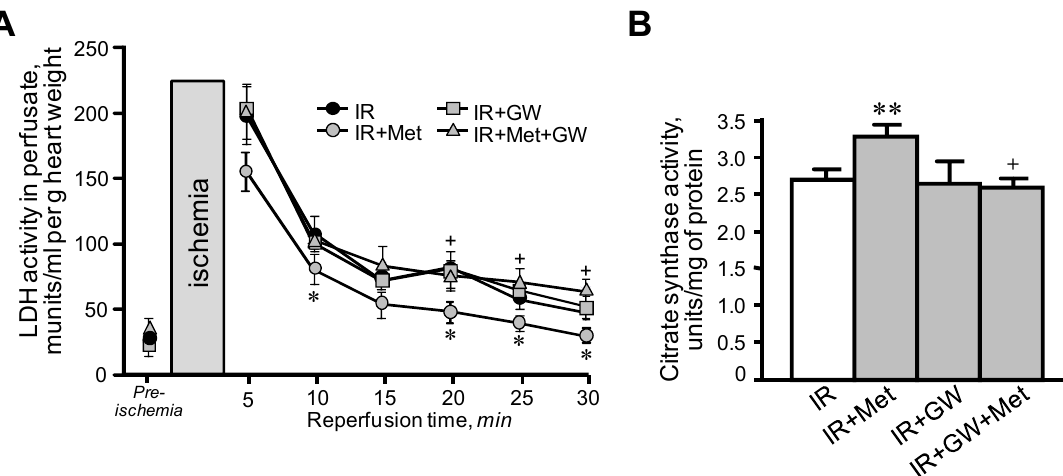
Figure 3. Lactate dehydrogenase (LDH) activity in eluates from hearts collected during reperfusion ( A ), and citrate synthase activity in the mitochondria ( B ) isolated from IR hearts treated with metformin (Met) in the presence or absence of GW6471 (GW). Enzyme activity is shown as munits/mL of perfusate per gram heart weight for LDH, and units per mg of mitochondrial protein for citrate synthase. * p < 0.05, ** p < 0.01 IR+Met vs. IR; + p < 0.05, ++ p < 0.01 IR+Met+GW vs.